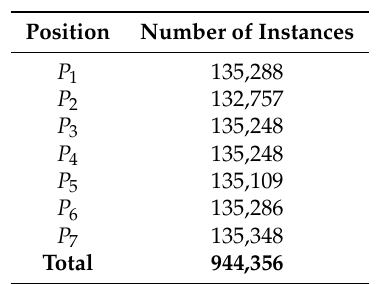
Table 2. Data distribution over the on-body positions deduced from the RealWorld HAR dataset [25].